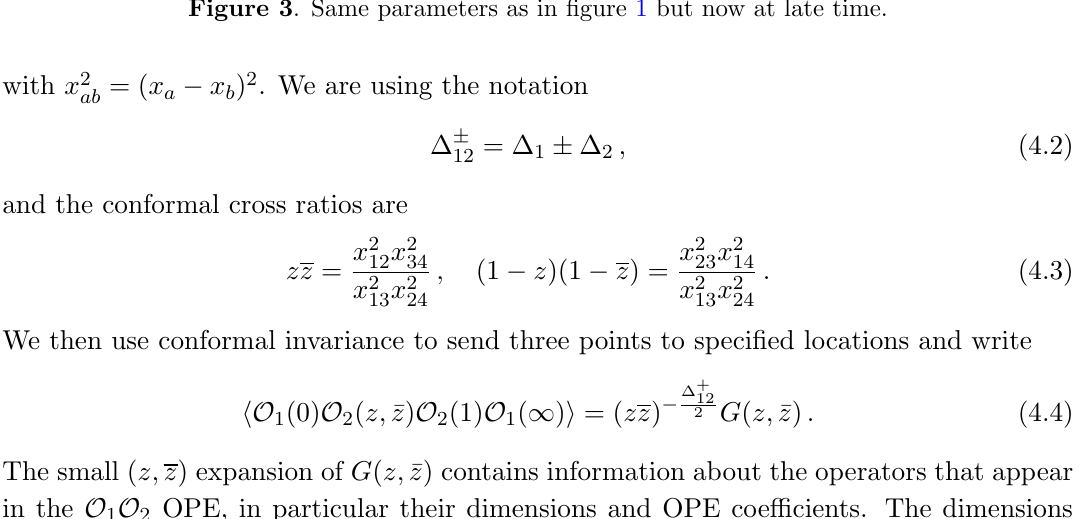
Figure 3 . Same parameters as in (cid:12)gure 1 but now at late